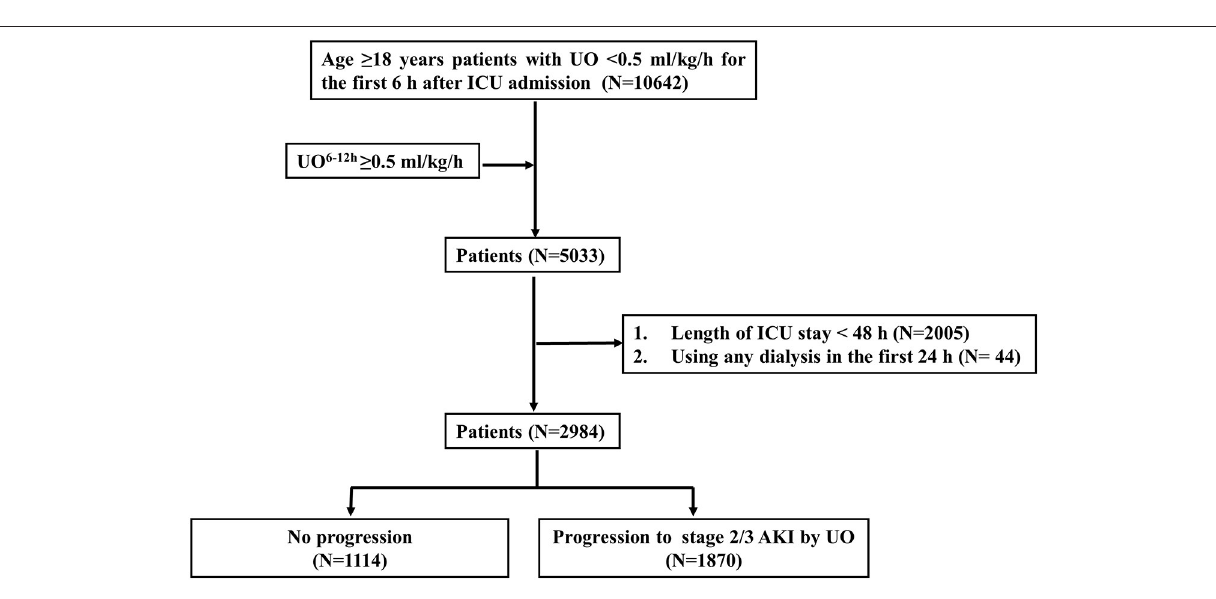
FIGURE 2 | Flowchart of patient selection. UO, urine output; UO 6 − 12h , urine output within 6h after diagnosis of AKI by KDIGO UO criteria; ICU, intensive care unit; AKI, acute kidney injury; KDIGO, Kidney Disease: Improving Global